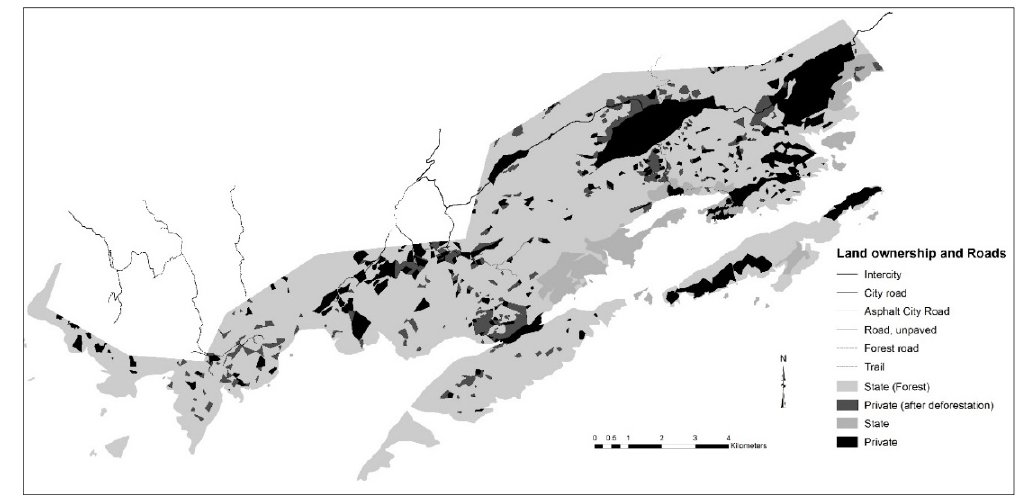
Figure 6. Land ownership pattern classified according to the land registry type (i.e., forest or cadastral) and owner type (i.e., owned by state or private).